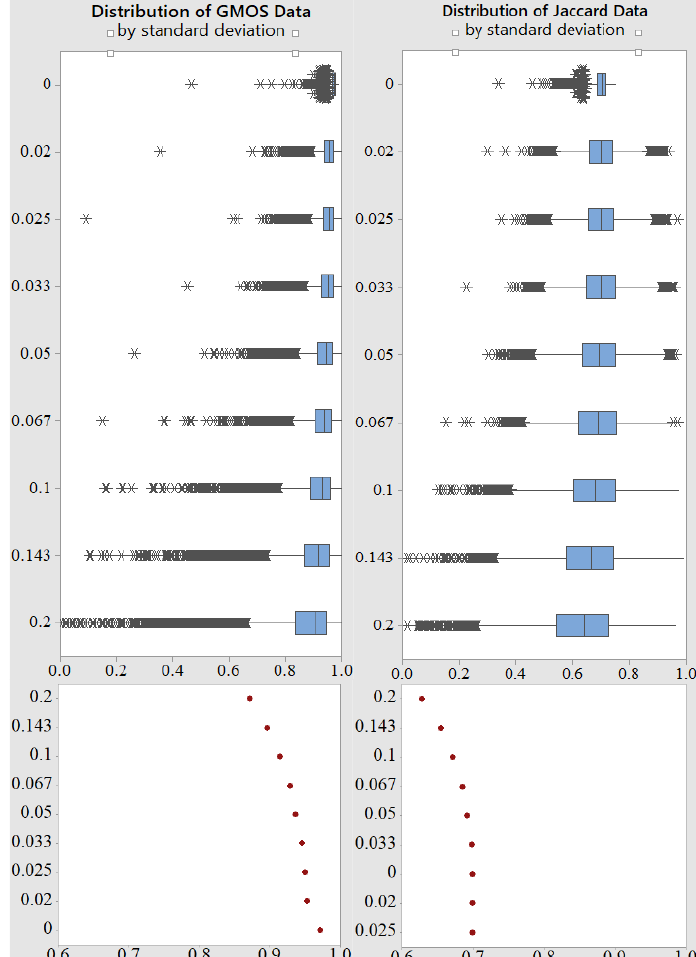
Figure 12. Comparison of frame data with position shift equal to 0.02 of diagonal length and corner disruption with mean equal to 0.02 and varying standard deviation. Left side —general measure histograms and mean comparison. Right side —Jaccard index histograms and mean